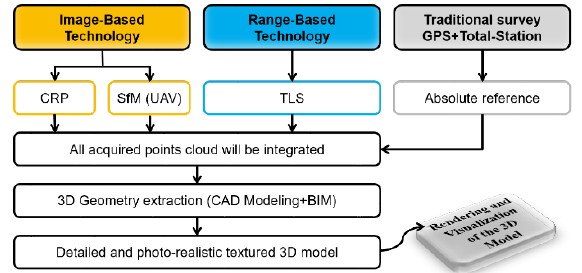
Figure 5. Integration of Range-Based, Image-Based